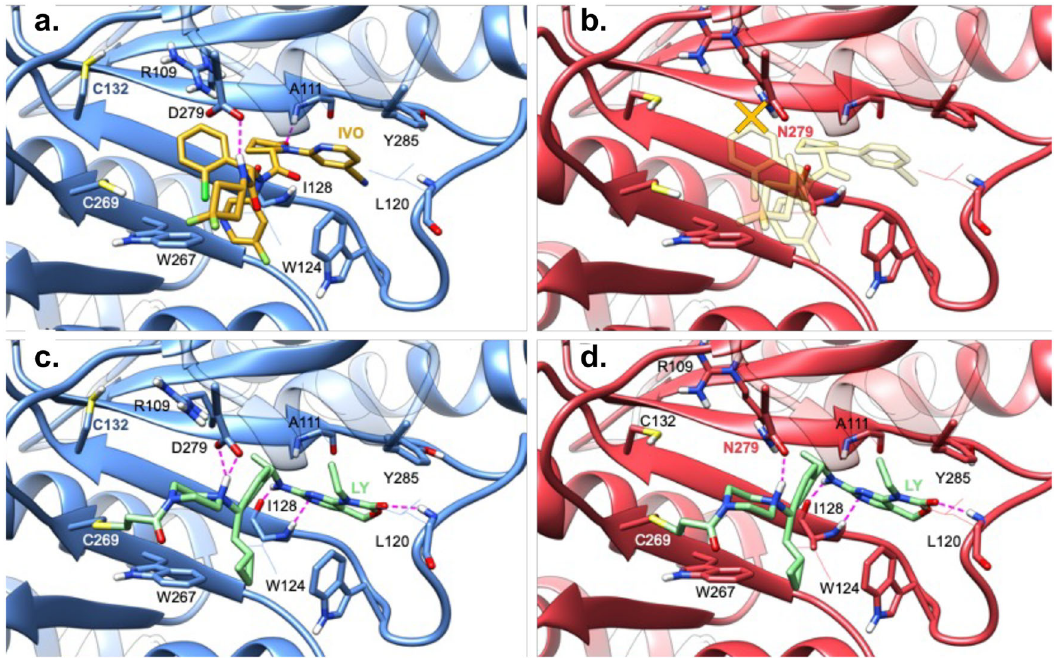
Fig. 5 In silico models of mutant IDH1 inhibitors inside the allosteric sites of IDH1 R132C and IDH1 R132C/D279N. a Predicted binding mode of ivosidenib (IVO, carbons in yellow) in the allosteric site of IDH1 R132C (carbons in blue). IVO is recognized by IDH1 R132C principally by donating a hydrogen bond to the IDH1 D279 side chain and accepting a hydrogen bond from the IDH1 A111 backbone. Further speci fi c intermolecular interactions involve aromatic contacts with IDH1 W267, IDH1 W124, and IDH1 Y285. b IVO is predicted to have impaired binding to IDH1 R132C/D279N (carbons in red) because the chlorophenyl ring clashes with the mutated asparagine side chain (orange X). c Predicted binding mode of LY3410738 (LY, carbons in green) in the allosteric site of IDH1 R132C (carbons in blue). LY3410738 covalently binds to IDH1 C269 and displays many favorable electrostatic interactions with the protein: the protonated piperazine makes an ionic interaction with the IDH1 D279 side chain and the inhibitor additionally makes two hydrogen bonds with the IDH1 I128 backbone and accepts a hydrogen bond from the IDH1 L120 backbone. d LY3410738 is predicted to adopt a similar covalent binding mode to IDH1 R132C/ D279N as it does to IDH1 R132C by keeping all of its numerous anchor points and by replacing the ionic interaction with aspartate with a hydrogen bond to the oxygen of the asparagine-mutated side chain at position